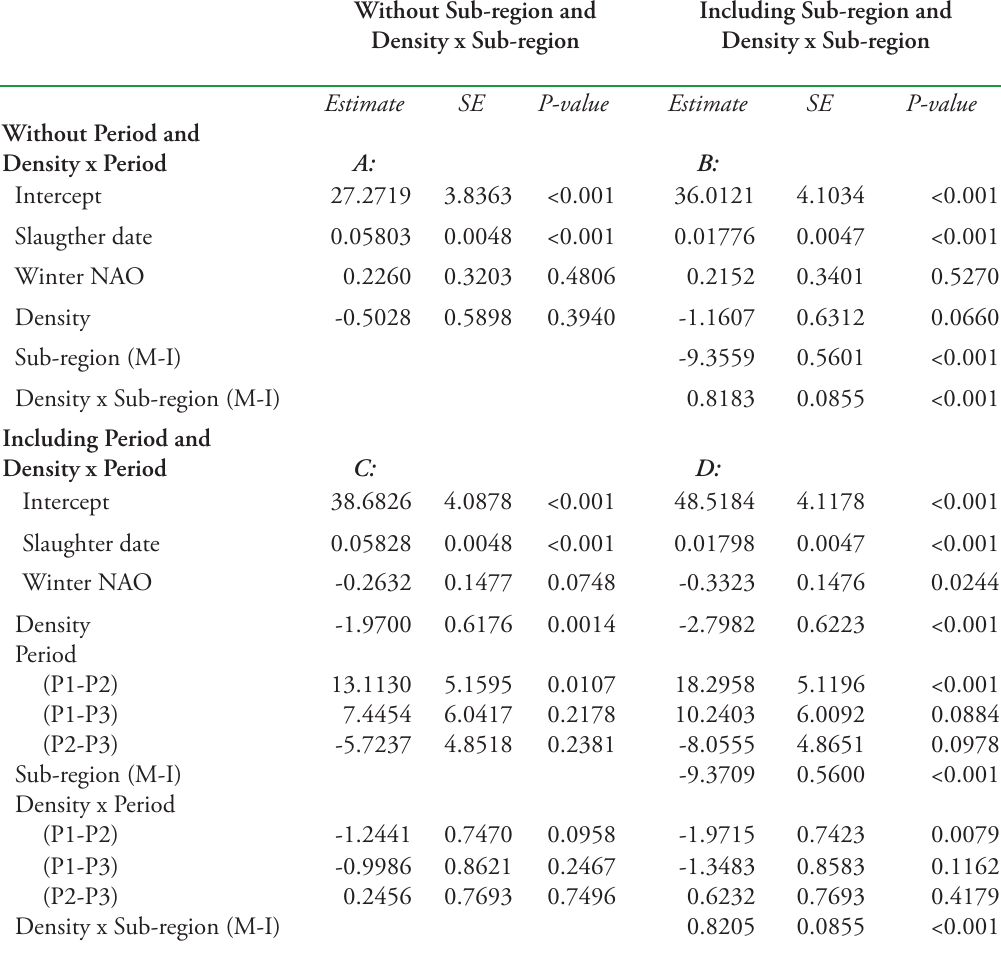
Table 2. Parameter estimates with standard errors (SE) and P -values for the mixed linear models fitting the autumn carcass masses (kg) of male yearlings at the coarse density scale (i.e. West Finnmark ) without sub-region (mainland: M and island: I) and period (P1: 1983-86, P2: 1996-2001; P3: 2002-2004) and theirs interactions with density ( A: ), including sub-region and density by sub-region interaction ( B: ), without period and density by period interaction ( C: ), and with sub-region and period and theirs interactions with density ( D: ). Slaughter date and winter NAO are entered as covariates in the